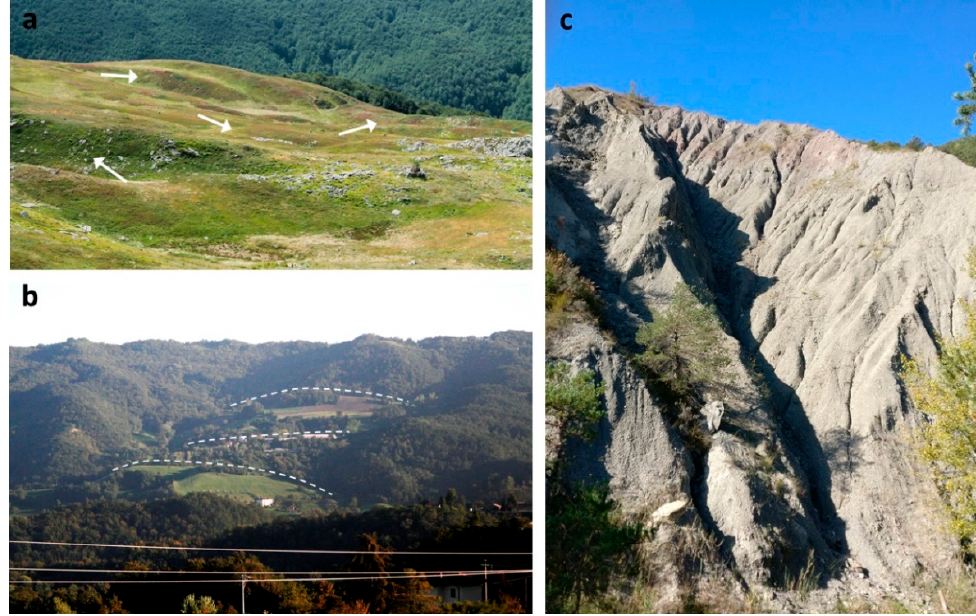
Figure 5. Selection of surface features on the studied DSGSDs: ( a ) counterscarps and trenches on the upper Ozola DSGSD (indicated by the arrows); ( b ) blocks of rocks separated by trenches and counterscarps on the Carpineti DSGSD (dashed lines); ( c ) vertical fractures on the main body of the Marola DSGSD; note the formation of badlands in the vicinity of fractures.